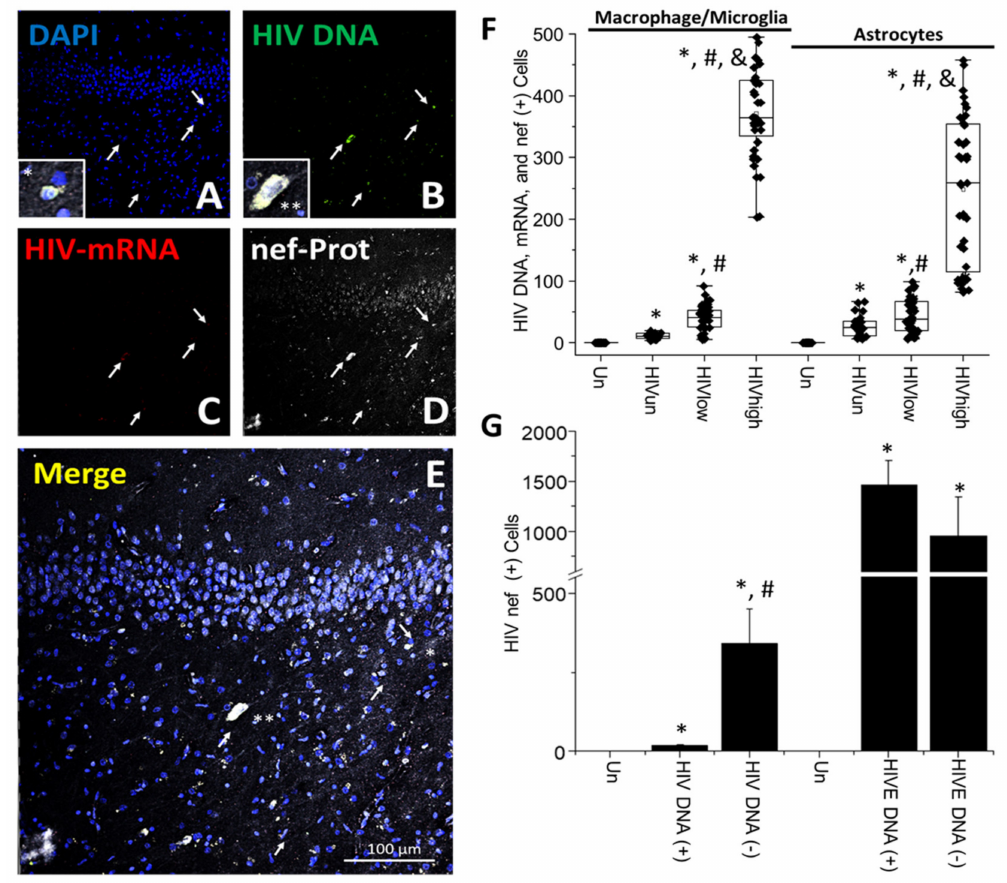
Figure 5. HIV-nef is expressed in HIV-infected and surrounding uninfected cells, even in ART conditions. ( A – E ) Representative confocal images show the expression and distribution of nef protein in the HIV-infected cells. Labeling corresponds to ( A ) DAPI, ( B ) HIV DNA, ( C ) HIV-mRNA, and ( D ) HIV-nef protein showing wide distribution in cells containing integrated HIV DNA (white arrows) and cells without integrated DNA, and ( E ) merging of all colors. The asterisks (* and **) and arrows represent cells with a high HIV-nef protein expression. The insets show cells with DAPI, HIV DNA, and HIV-nef protein. ( F ) Quantification of cells with integrated HIV DNA, viral mRNA, and HIV-nef protein in microglia/macrophages and astrocytes according to the tissue analyzed based on systemic replication, including undetectable, low, and high replication (* p ≤ 0.005 compared to uninfected conditions, # p ≤ 0.005 compared to HIV un conditions, and & p ≤ 0.005 compared to HIV un or HIV low conditions; n = 34 tissues analyzed and 21 tissues compared to uninfected tissues, Un and Alz, n = 8 different tissues; each point represents 3–5 different areas per tissue analyzed). ( G ) Quantification of cells positive for HIV-nef protein in HIV-infected cells (HIV DNA (+)) was 17.15 ± 2.81 cells compared to neighboring uninfected cells (HIV DNA ( − )) containing HIV-nef protein 341.63 ± 107.68 cells. This indicates a strong nef expression within the CNS in the current ART era, especially in neighboring uninfected cells. * p ≤ 0.005 compared to uninfected conditions, # p ≤ 0.005 compared to HIV un conditions. Bar: 100 µ m.